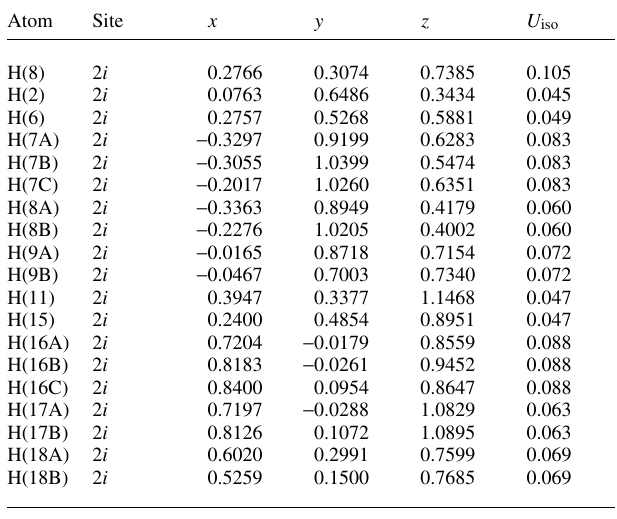
Table 1. Data collection and